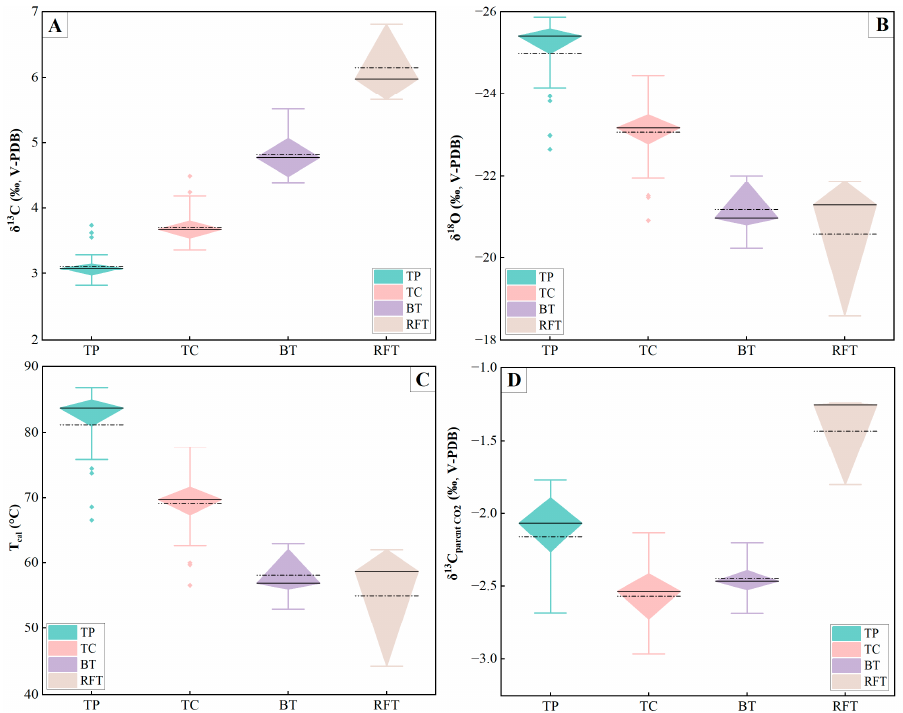
Figure 4. δ 13 C and δ 18 O of thick-laminated palisade crystalline crust, thin-laminated composite crys- talline crust, bedded travertines and recently formed travertines at Xiagei. n = the number of sam- ples.